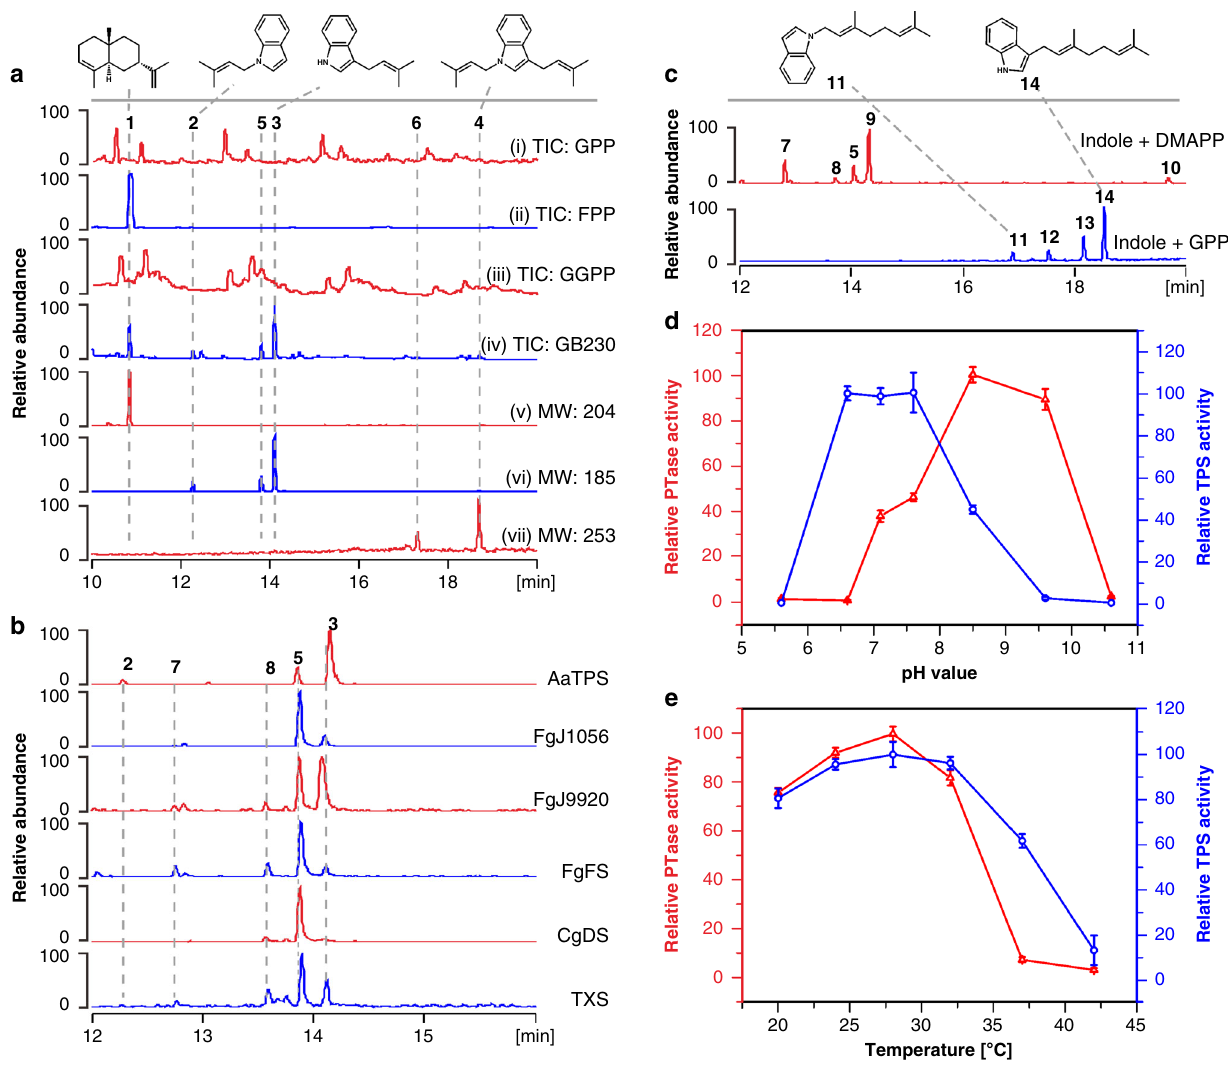
Fig. 2 Indole prenyltransferase activities of terpene cyclases. a GC/MS chromatogram of terpenes produced by in vitro assay of AaTPS with (i) GPP, (ii) FPP and (iii) GGPP, respectively. Peaks shown in (i) and (iii) correspond to background, (iv), compounds produced by AaTPS overexpression in E. coli GB230, (v) sesquiterpene compound 1 produced by E. coli GB230, (vi) prenylindoles 2 , 3 , and 5 with molecular weight (MW) 185 produced by E. coli GB230, and vii) prenylindoles 4 and 6 with MW 253 produced by E. coli GB230. b , GC/MS chromatogram of prenylindoles 2 , 3 , 5 , 7 , and 8 with MW 185 produced by AaTPS, FgJ1056, FgJ9920, FgFS, CgDS, and TXS while using indole and DMAPP as co-substrates. c GC/MS chromatogram of prenylindoles produced by in vitro assay of FgGS. Prenylindoles 5 , 7 , 8 , 9 with MW 185 and 10 with MW 253 were detected when indole and DMAPP were used as co- substrates, and prenylindoles 11 – 14 with MW 253 were produced when indole and GPP were used as co-substrates. d pH-Dependent assays of terpene cyclase and indole prenyltransferase activities of AaTPS. e Temperature-dependent assays of terpene synthase and indole prenyltransferase activities of AaTPS. PTase represents prenyltransferase, TPS represents terpene synthase. Relative abundance and relative activities are shown in this fi gure; the compound with the highest abundance or the enzyme with the highest activity is set as 100. Data represent the means ± standard deviation (SD) of three biological replicates. Source data are provided as a Source Data fi